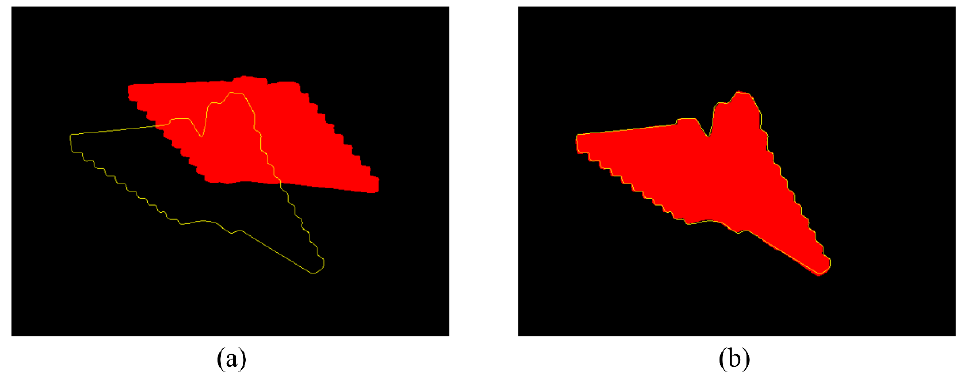
Figure 10. Case of automatic calibration of thermogram B: ( a ) Initial projection of 3D points, using a set of initial extrinsic parameters; ( b ) Projection utilizing the parameters for which the objective function of Equation (1) presents a global minimum.